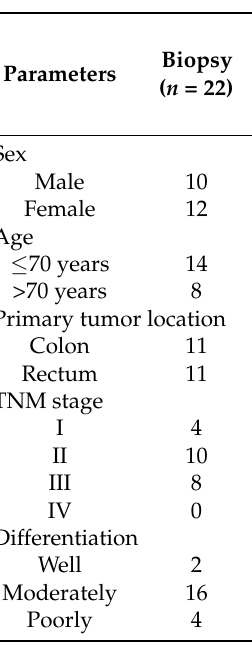
Table 1. Characteristics of patients and specimens that were included in the present